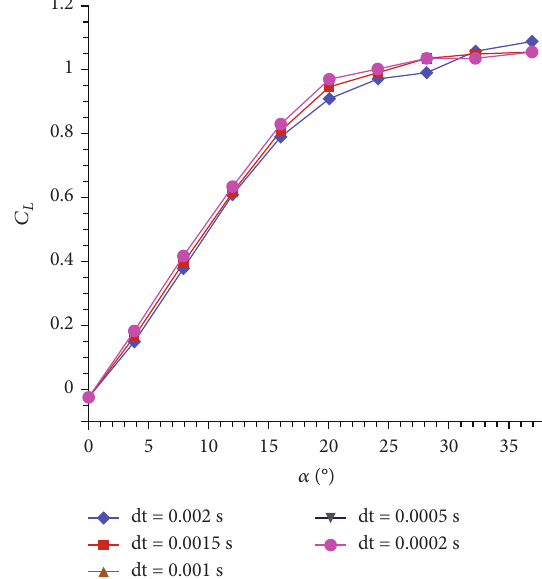
Figure 14: Lifts of di ff erent time step